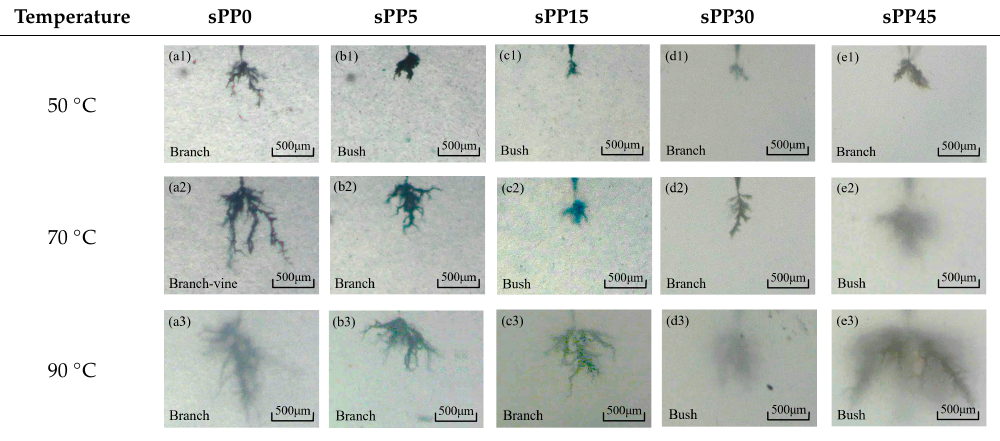
Figure 4. Variation of electrical tree length of different sPP contents at ( a ) 50 °C, ( b ) 70 °C, and ( c ) 90 °C under AC voltage of 6 kV.